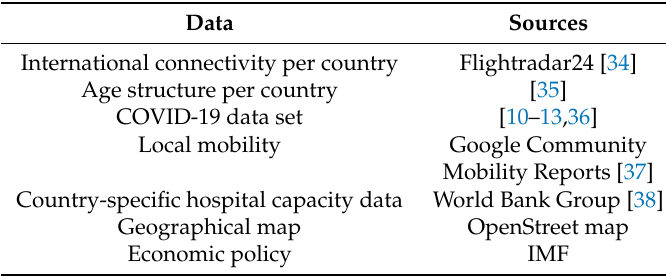
Figure 2. Pandemic vs. Economic Consequences of COVID-19. Table 2. Heterogenous data